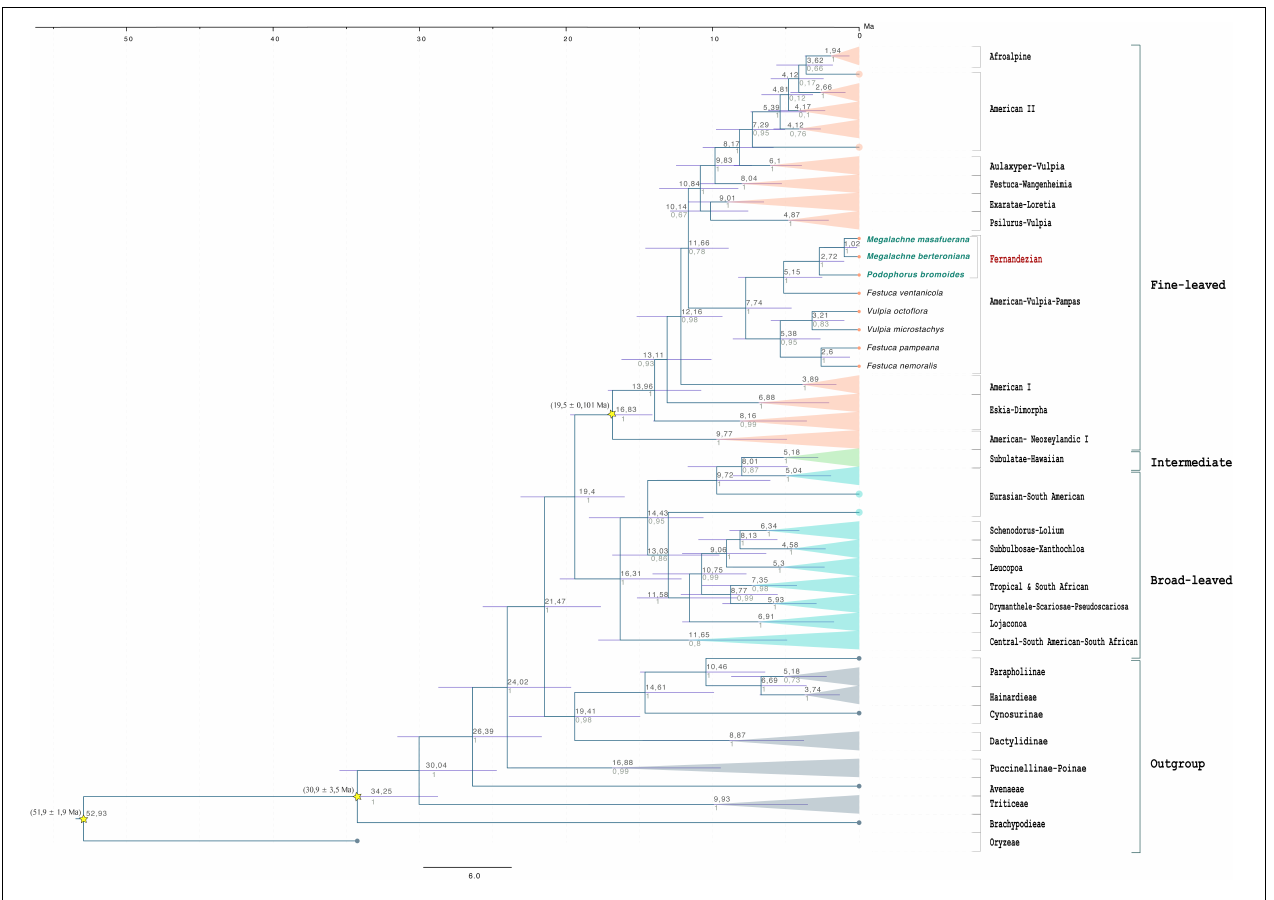
FIGURE 4 | Schematic Bayesian maximum clade credibility dated chronogram of 135 Loliinae taxa constructed with BEAST2 using nuclear ITS and plastid TLF loci showing estimated nodal divergence times (medians, in Ma) and 95% highest posterior density (HPD) intervals (bars) above branches and Posterior Probability Support (PPT) values below branches. Stars indicate secondary nodal calibration priors (means ± SD, in Mya) for the crown nodes of the BOP, Brachypodium + core pooids, and fine-leaved Loliinae